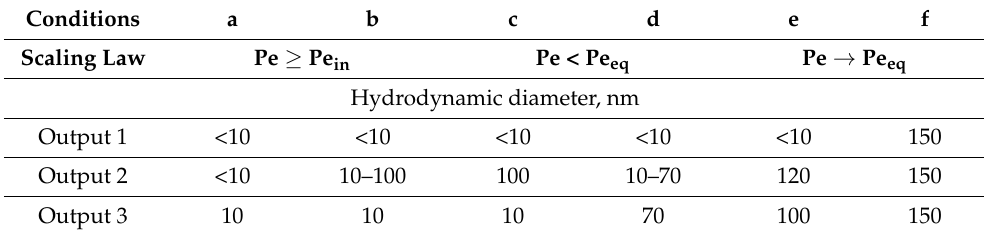
Table 1. Detection of chemical signals by dynamic light